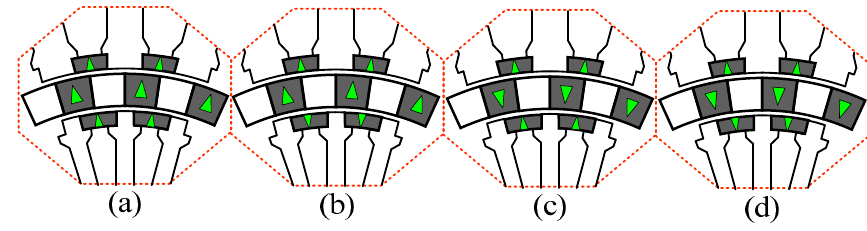
Figure 3. Magnetization patterns. ( a ) Model 1; ( b ) Model 2; ( c ) Model 3; ( d ) Mode 4.